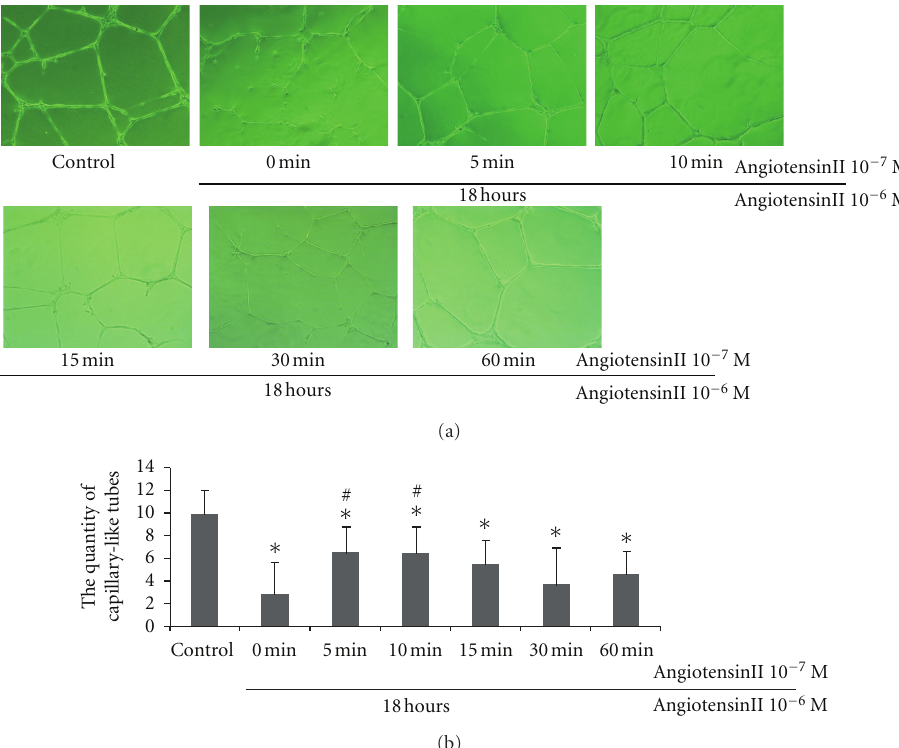
Figure 1: Time-dependent e ff ects of AngII preconditioning on AngII-induced impairment of capillary-like tube formation in cultured CMVECs. CMVECs were pretreated with AngII (10 − 7 M) for the indicated times and then seeded onto the matrigel in plates containing AngII (10 − 6 M) or not (control). Eighteen hrs later, the formation of capillary-like tubes was observed under an optical microscope. (a) Representative photomicrographs of capillary-like tubes (100xmagnification). (b) Quantitative analysis for capillary-like tube formation. Capillary-like tubes were counted in randomly selected 5 fields for each plate. Data represent mean ± SD obtained from 15 independent experiments ( n = 15); ∗ P < 0 . 05 versus control group; # P < 0 . 05 versus the group without AngII pretreatment